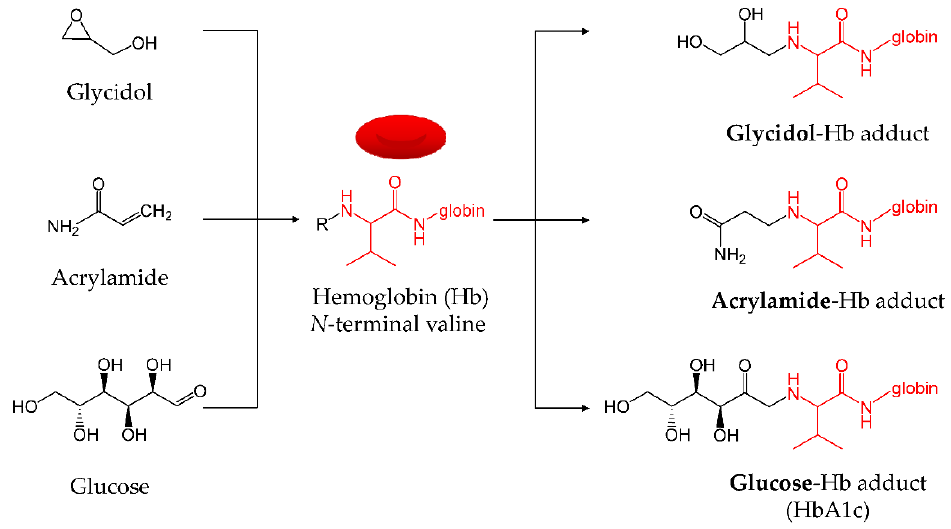
Figure 1. Chemicals that form adducts with the N-terminal valine of Hb.